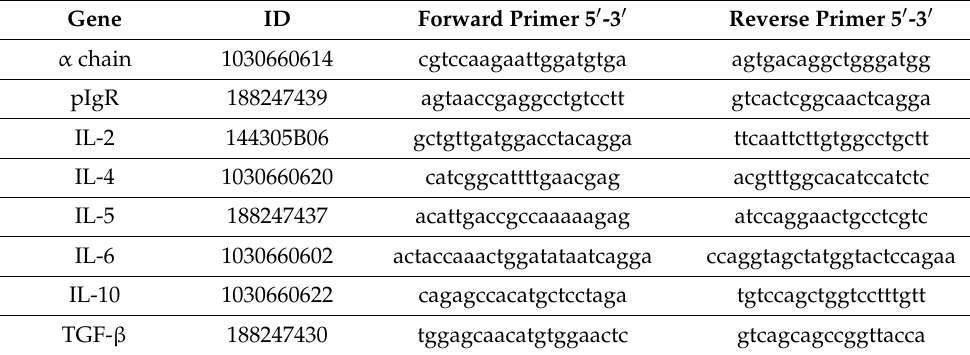
Table 1. mRNA expression of